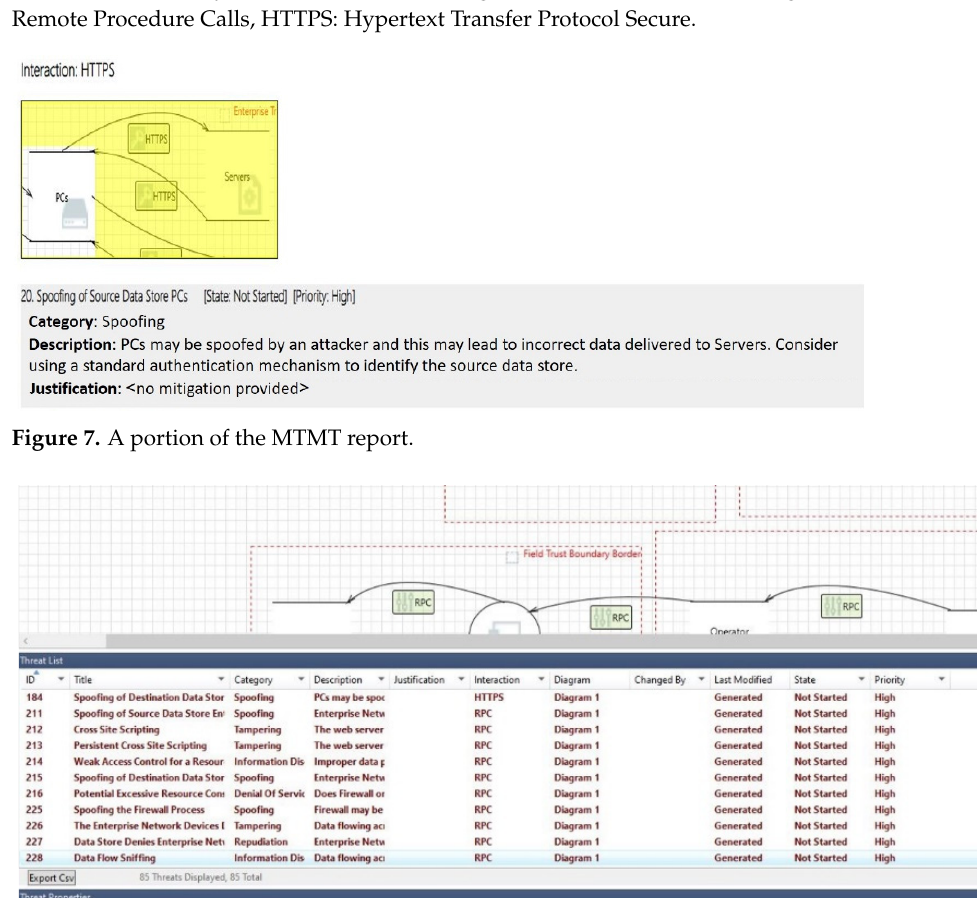
Figure 8. An image of the threat list in the MTMT program.